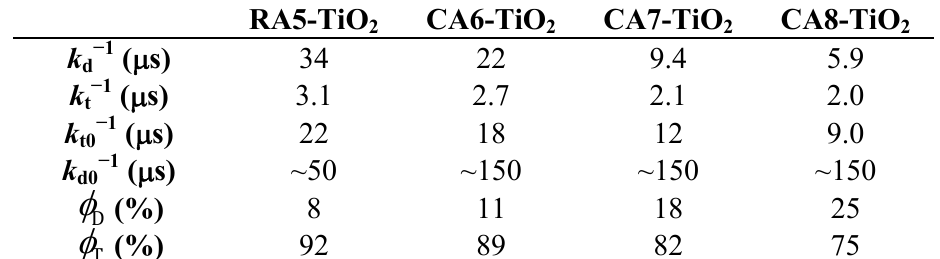
Table 3. The time constants of transformation from the D  1 and k  1 ) and the D states ( k d t